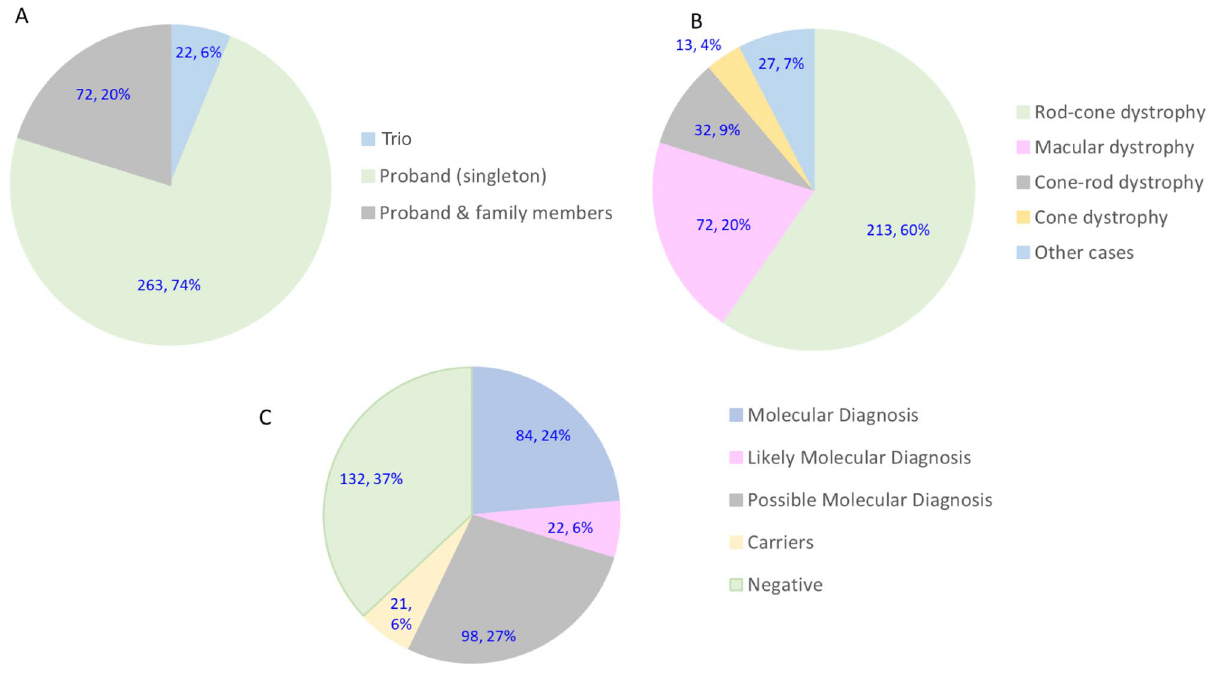
Figure 1. ( A ) Samples sent for clinical ES testing, ( B ) phenotypes seen in the cohort, ( C ) categorization of ES